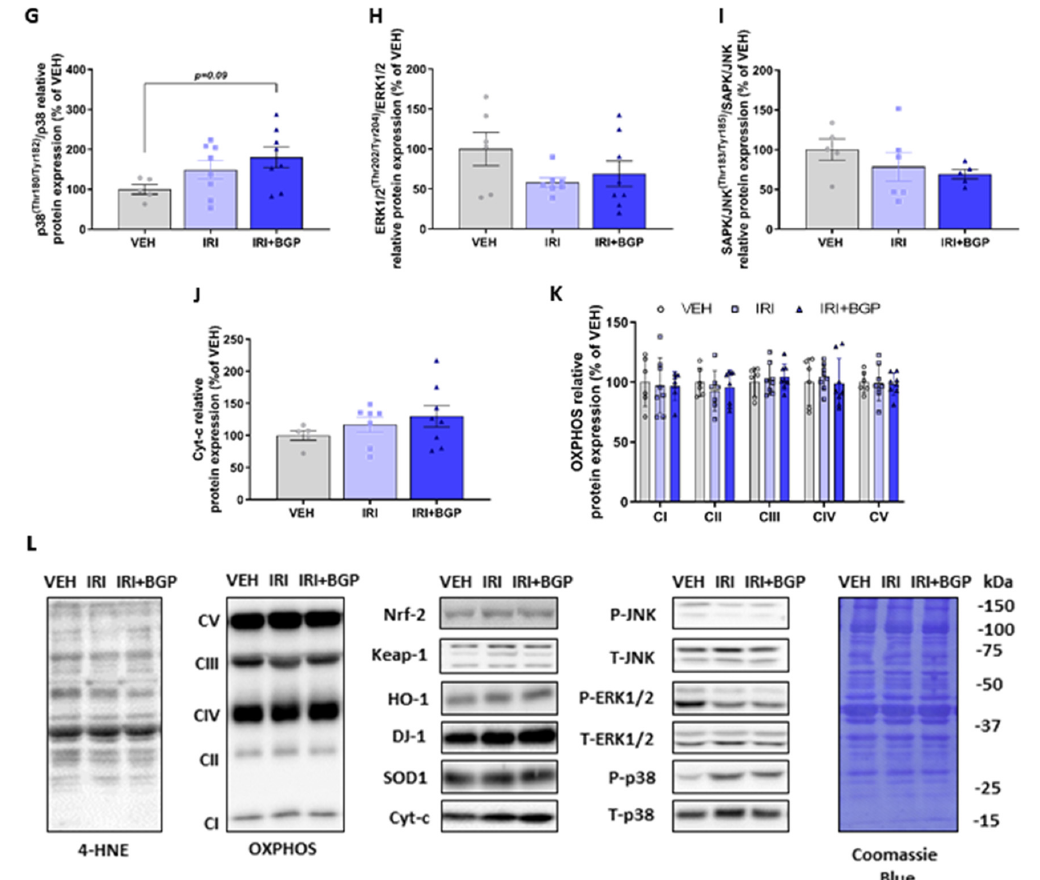
Figure 7. The effect of irinotecan (IRI) and IRI with BGP-15 (IRI+BGP) treatment on oxidative and mitochondrial stress signaling pathways. Western blotting experiments were undertaken and tibialis anterior (TA) homogenate was probed for oxidative stress signaling markers; ( A ) 4-Hydroxynoneal (4-HNE), ( B ) nuclear factor erythroid 2 (NFE2)-related factor 2 (Nrf-2), ( C ) hemeoxygenase-1 (HO-1), ( D ) superoxide dismutase-1 (SOD1), ( E ) Kelch-like ECH-associated protein 1 (Keap-1), ( F ) protein deglycase (DJ-1), and mitogen-activated protein kinases (MAPKs)—which are sensitive to oxidative stress—( G ) p38 (Thr 180 /Tyr 182 ) relative to total p38, ( H ) extracellular signal-regulated protein kinase (ERK1/2; Thr 202 /Tyr 204) relative to total ERK1/2 and ( I ) c-Jun N-terminal kinase (JNK;Thr 183 /Tyr 185 ) relative to total JNK are displayed. Additionally, mitochondrial stress and content markers ( J ) Cyt-c and ( K ) the OXPHOS cocktail, i.e., Complex V (CV) subunit ATP5A, Complex IV (CIV) subunit MTCO1, Complex III (CIII) subunit UQCRC, Complex II (CII) subunit SDHB and Complex I (CI) subunit NDUFB8, were probed for. These data are expressed as a relative percentage of the vehicle (VEH) control group. ( L ) Western blot representative images are displayed alongside a Coomassie Blue representative image, which was used as the protein loading control. * = p < 0.05 compare to VEH; n = 5–8.